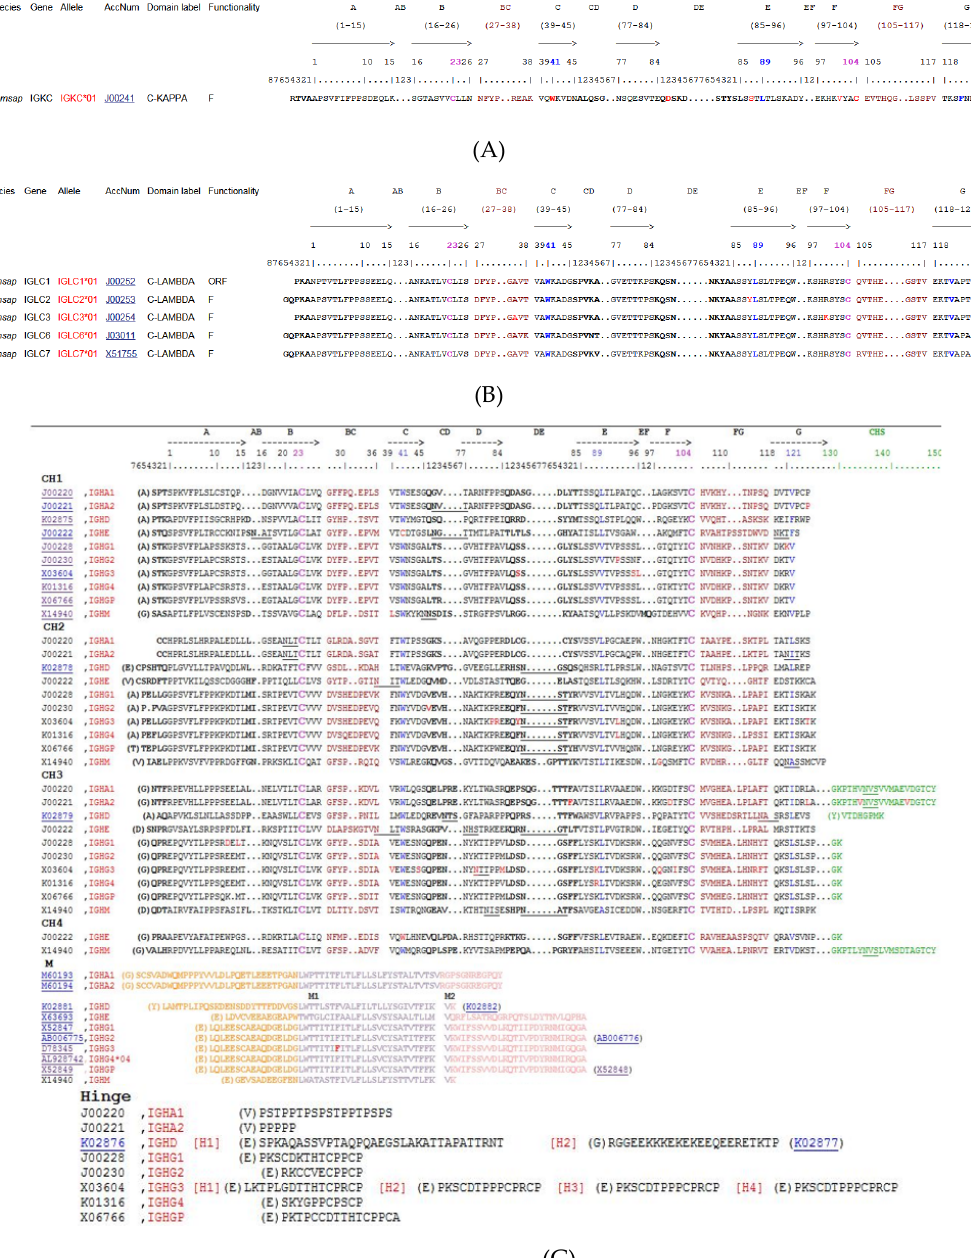
Figure 24. IMGT Protein displays of the Homo sapiens IGKC, IGLC and IGHC genes. ( A ). IGKC Protein display. Ala A45.1 and Val V101 characterize the Km3 allotype (see Section 3.3.4). ( B ). IGLC Protein display. Asn N1 and Thr T3 characterize the Mcg isotype marker, Gly G45 characterizes the Ke isotype marker, and Lys K100, the Oz isotype marker (see Section 3.4.4). ( C ). IGHC Protein display. The IGHC Protein display is shown per domain (CH1, CH2, CH3, and for IGHM and IGHE, CH4). The CO + TM + CY of the membrane IG (mIG) is encoded by two exons, excepted for IGHA1 and IGHA2 where it is encoded by a single exon. The CHS of the sIG is colored in green. The hinge region (presented here, at the bottom of the figure) is located between CH1 and CH2. It is encoded by one exon (in IGHG1, IGHG2, IGHG4, IGHGP genes), two exons (in IGHD gene), two to five exons (in IGHG3 gene, 4 for the most common haplotype, shown here). The hinge region of the IGHA1 and IGHA2 is fused in 5 ′ to the CH2 domain (encoded in a H ‐ CH2 exon) [2]. The IGHGP, although an ORF, is shown for compleness. The C ‐ KAPPA, C ‐ LAMBDA and CH are numbered according to the IMGT unique numbering for C ‐ DOMAIN and C ‐ LIKE ‐ DOMAIN [42]. The header of the IMGT Protein display of the C ‐ DOMAIN obtained automatically (A and B) comprises 5 lines. Line 1: name of strands (A, B...), turns and loops (AB, BC...). Line 2: start and end positions of strands, e.g. (1 ‐ 15). Line 3: arrows (for the strands). Line 4: positions according to the IMGT unique numberin[42]. Missing positions (32 and 33 in the BC loop and 46 to 76) in the C domain by comparison with the V domain are not shown. Line 5: Pipes for the start and end positions of strands and loops and highlighted positions, and dots for the other positions (dots indicate gaps according to the IMGT unique numbering [42]). The four conserved amino acids 23 (1st ‐ CYS), 41 (CONSERVED ‐ TRP), 89 (hydrophobic) and 104 (2nd ‐ CYS) are highlighted (C23 and C104 in pink, W41 and hydrophobic 89 in blue). The IMGT Protein display of the Homo sapiens IGHC obtained manually (C) allows to display the CHS, the CO+TM+CY and the hinge. The N ‐ linked glycosylation motifs (NXS/T, where X is different from P) are underlined. In the automatic version for the CH displayed online, the letter N (Asn, asparagine) of potential N ‐ glycosylation sites are shown in green. (With permission from M ‐ P. Lefranc and G. Lefranc, LIGM, Founders and Authors of IMGT ® , the international ImMunoGeneTics information system ® , http://www.imgt.org).